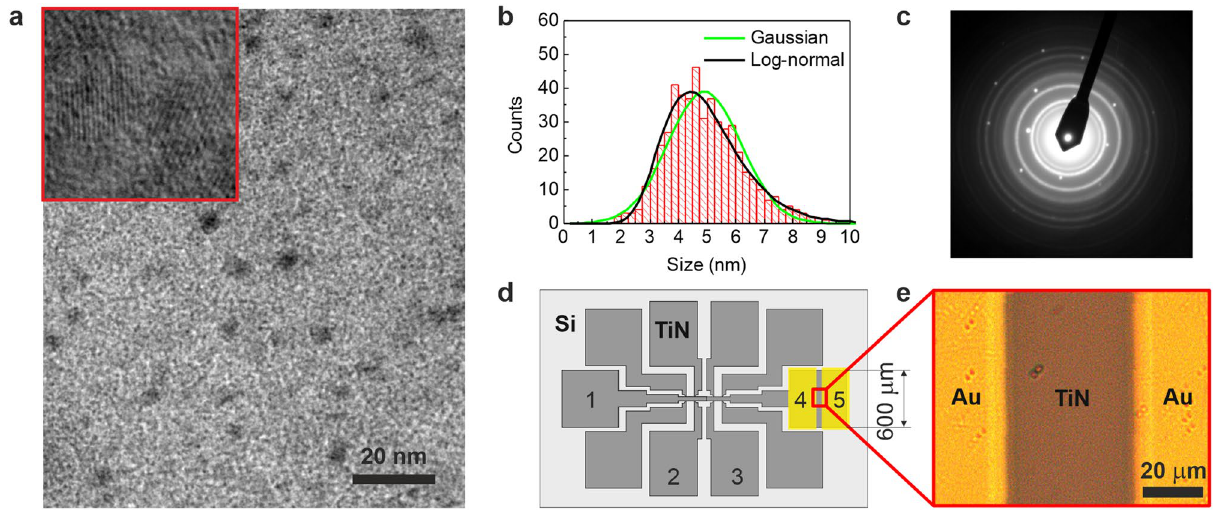
Figure 1. Experimental setup and film characteriization. ( a ) High resolution transmission electron micrograph of the plan view of the initial as-grown TiN film showing the polycrystalline structure, which is distinctly 2 visible in the top-left corner inset in the image. The full size of the inset image is 20 × 20 nm . ( b ) Histogram of the crystallite size distribution (the sampling number is 500). Note that the histogram is slightly asymmetric. The solid green and black curves represent the best fits by Gaussian and log-normal distribution functions, respectively. Gaussian distribution yields the average of the crystallite size of 4.9 nm with the standard deviation of 1.3 nm. Log-normal distribution produces 4.8 nm for the median crystalline size and 1.3 for geometric standard deviation. ( c ) Transmission electron-diffraction pattern of the film. The rings are characteristic to polycrystalline structures and correspond to fully stoichoimetric composition of the TiN film, while the point reflexes comprising a square array correspond to the crystalline lattice of the Si-substrate. ( d ) The layout of the sample prepared by the conventional UV lithography and plasma etching and displaying arrangement of the